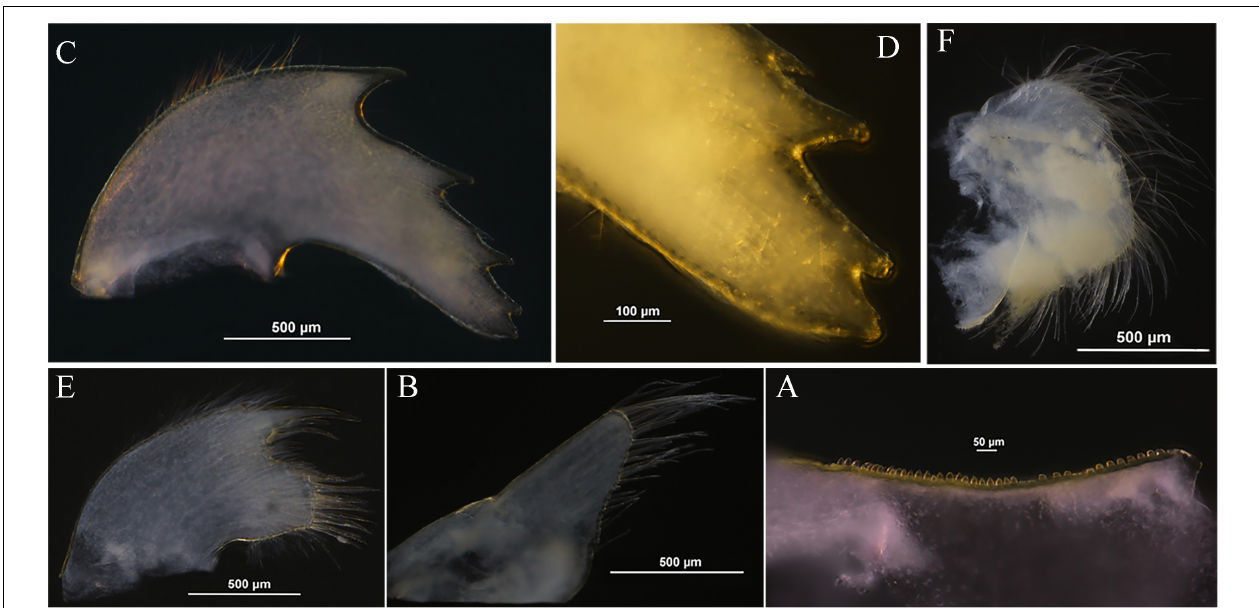
FIGURE 6 | Glyptelasma robustum sp. nov. holotype. (A) Inner edge of labrum. (B) Palp. (C) Mandible. (D) Inferior angle of mandible. (E) Maxillule. (F)